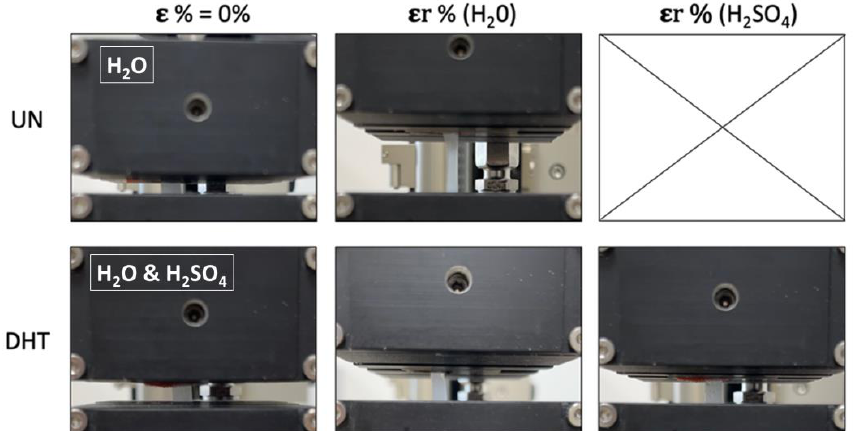
Figure 6. A representative snapshot of uncrosslinked and cross-linked collagen matrices at ε % = 0% and at their maximum deformation before the break in the presence of water and aqueous electrolytes (the snapshot of the UN membrane at ε % = 0% is referred to the sample impregnated with H 2 O since with H 2 SO 4 it was not possible to perform measurements; the snapshot of the DHT membrane at ε % = 0% is referred to sample impregnated with both H 2 O and H 2 SO 4 since no significant differences were